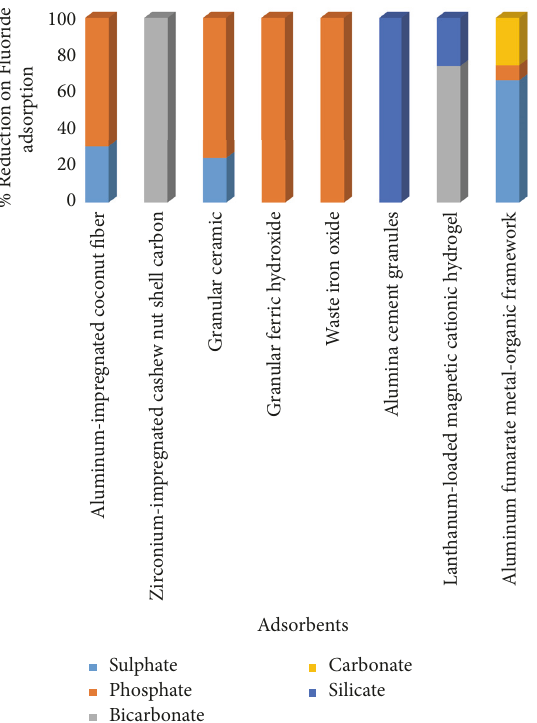
Figure 5: Effects of coexisting anions on fluoride removal on different